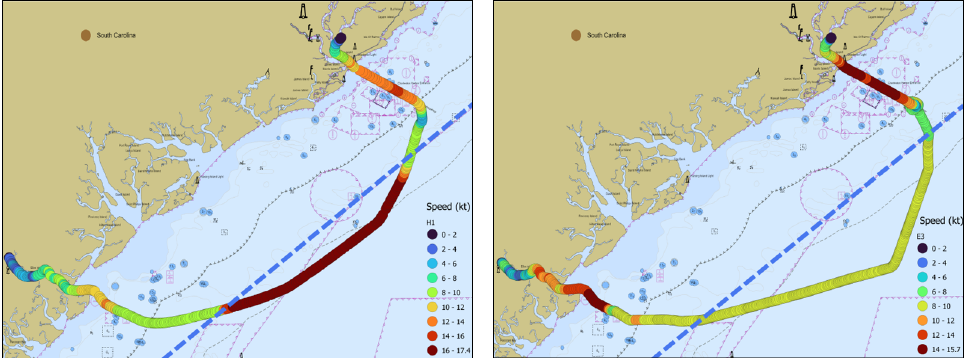
Figure 8. Trajectory profile for shortest (H1–( left )) and longest route (E3–( right )) with Speed Over Ground (SOG) in knots for individual AIS observations throughout the voyage (scale 1:600000).